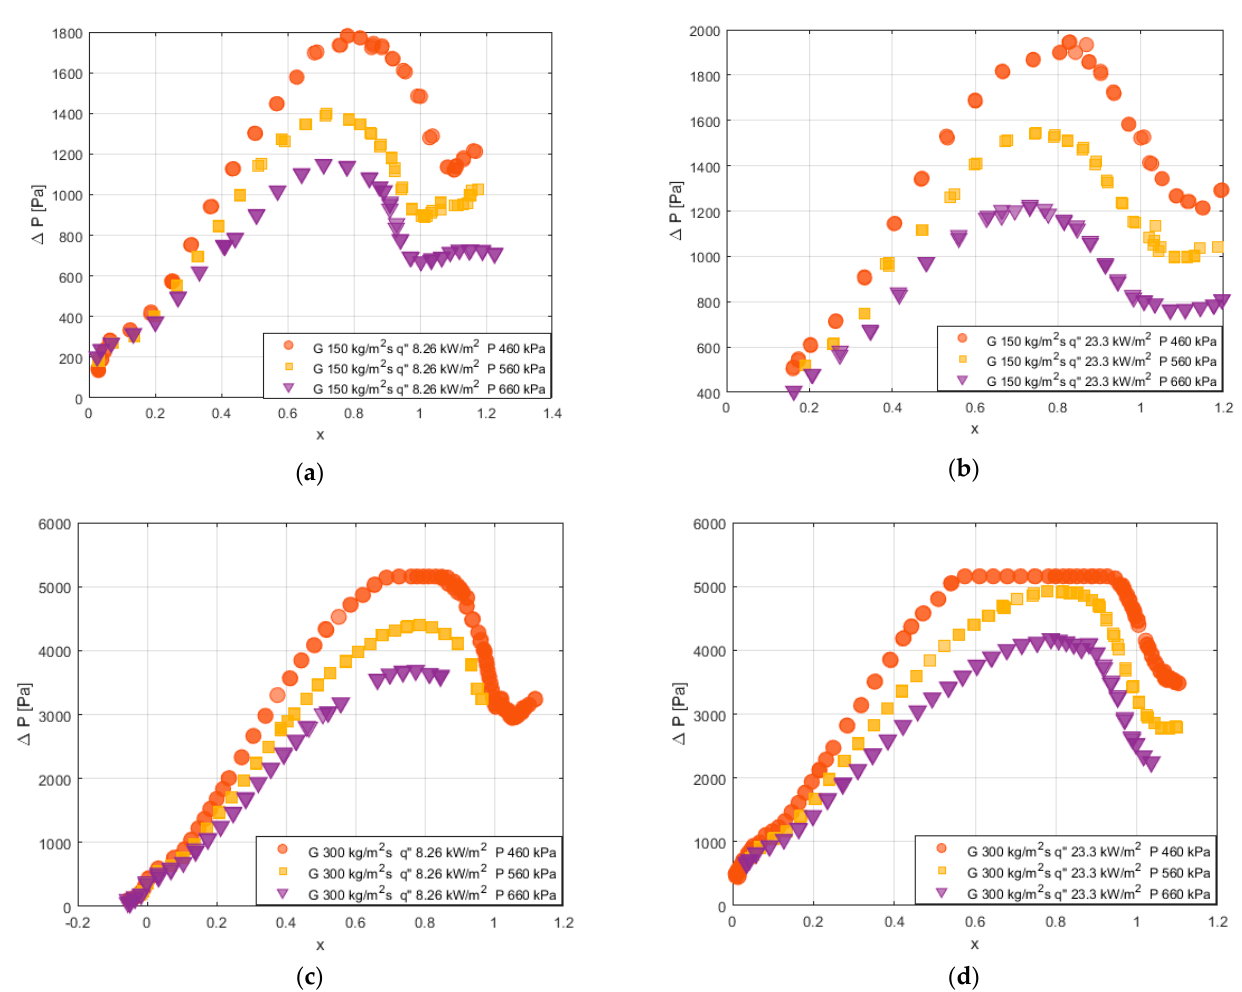
Figure 10. Effect of saturation pressure on adiabatic frictional pressure drop at ( a ) G 150 kg/m 2 s, q ″ 8.26 kW/m 2 , ( b ) G 150 kg/m 2 s, q ″ 23.3 kW/m 2 , ( c ) G 300 kg/m 2 s, q ″ 8.26 kW/m 2 and ( d ) G 300 q (cid:48)(cid:48) 8.26 kW/m 2 , ( b ) G 150 kg/m 2 s, q (cid:48)(cid:48) 23.3 kW/m 2 , ( c ) G 300 kg/m 2 s, q (cid:48)(cid:48) 8.26 kW/m 2 and kg/m 2 s, q ″ 23.3 kW/m 2 , ( d ) G 300 kg/m 2 s, q (cid:48)(cid:48) 23.3 kW/m 2